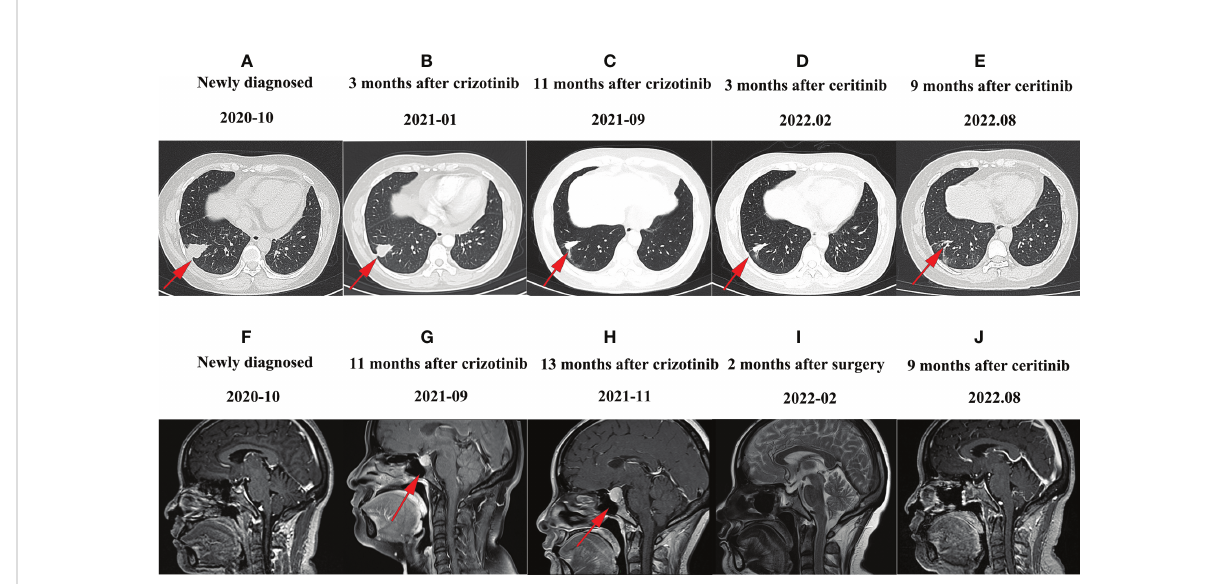
FIGURE 2 Representative CT or MRI images of the patient: (A) CT image of October 2020 before the treatment. (B) CT image of January 2021 after treatment with crizotinib. The therapeutic effect of the patients was evaluated as partial response. (C) CT image of September 2021 after pituitary metastases; the lung lesion was stable. (D) CT image of February 2022 after treatment with ceritinib; the lung lesions shrank further. (E) CT image of August 2022 after treatment with ceritinib; the lung lesion is still shrinking. (F) MRI image obtained in October 2020 before treatment; brain MRI showed no abnormalities. (G) MRI image of September 2021 after fi nding pituitary metastases. (H) MRI image after 1 month of supplemental hormone therapy. The pituitary gland was enlarged. (I) MRI image after sphenoid sinus exploration and nasal endoscopic saddle area tumor excision, and the brain MRI showed no mass. (J) Follow-up MRI images 9 months after tumor resection and 9 months after ceritinib administration.